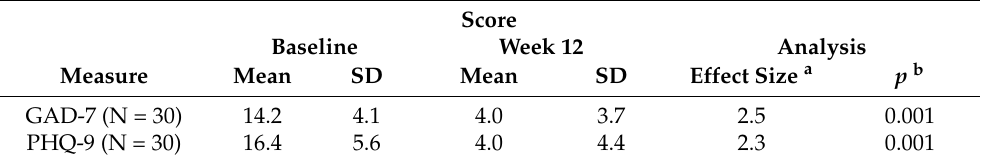
Table 2. Scores at Baseline and After 12 Weeks of Self-Attachment for 30 Subjects with Chronic Depression or Anxiety. Score Baseline Week 12 Analysis Measure Mean SD Mean SD Effect Size a p b GAD-7 (N = 30) 14.2